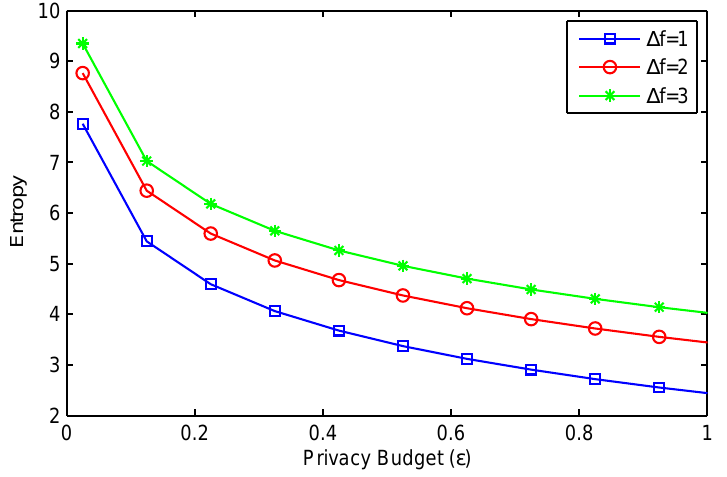
Figure 13. Utility metric 1 − NE of output of multivariate randomized response mechanism.